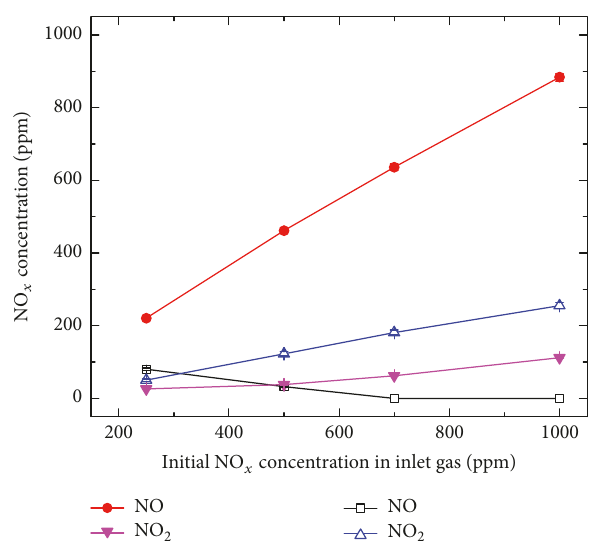
Figure 9: The change of NO concentration with the initial NO x x concentration (gas flow is 1.25 L/min, inlet O 2 concentration is 13%, inlet NO concentration is in the range of 250–1000 ppm, x NaClO concentration is 0.05 M, initial solution pH is 6, and solution temperature is 293 K; solid points refer to inlet NO concentrations x and open points refer to outlet NO concentrations). x